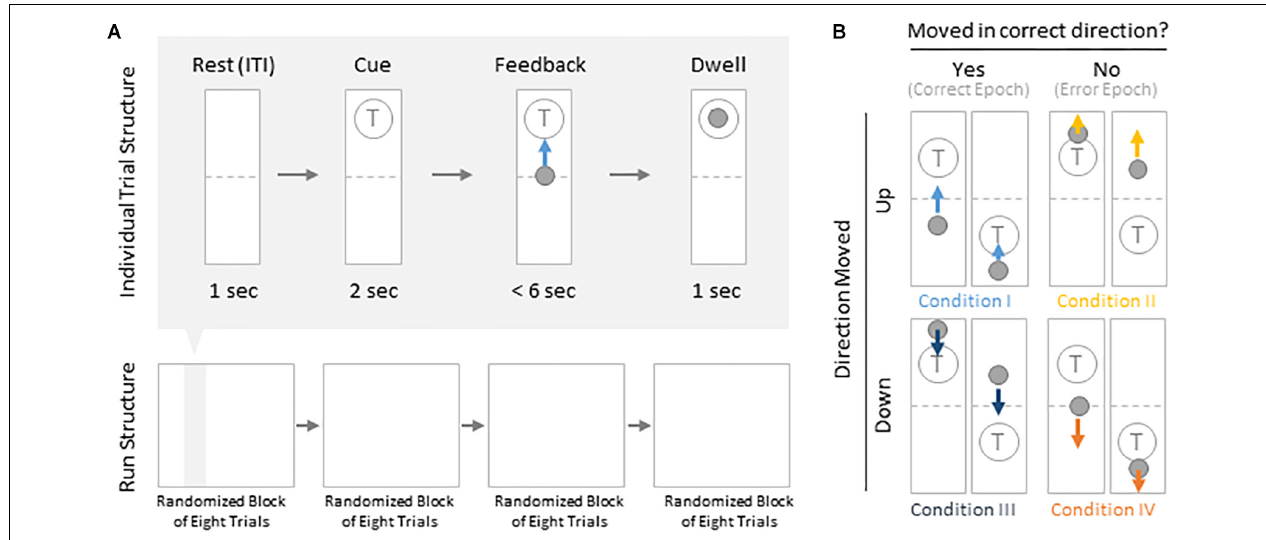
FIGURE 1 | Task structure and epoch conditions. (A) Subjects modulated cursor velocity in a one-dimensional center-out BCI task using imagined hand or tongue movement ( Table 1 ) in order to reach and dwell within a target. Cursor was re-centered prior to each trial and was not displayed during the inter-trial interval (ITI) and cue period. Trials were randomized to have the target located above or below the start position, near or far, and small or large. Trials were organized into four blocks, each containing eight randomized trials. (B) Within trials, data were binned into epochs based on four movement conditions: cursor moved up correctly (I, light blue), moved up erroneously (II, yellow), moved down correctly (III, navy blue), or moved down erroneously (IV, orange).